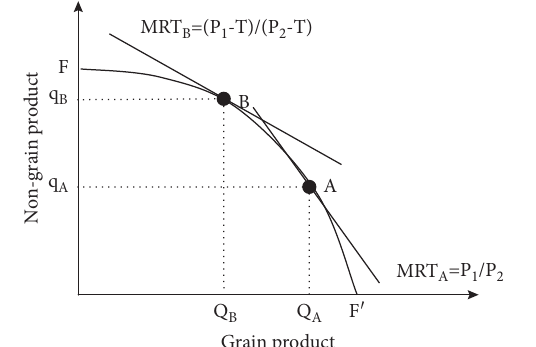
Figure 5: The increasing rental price causing an increase in nongrain production.